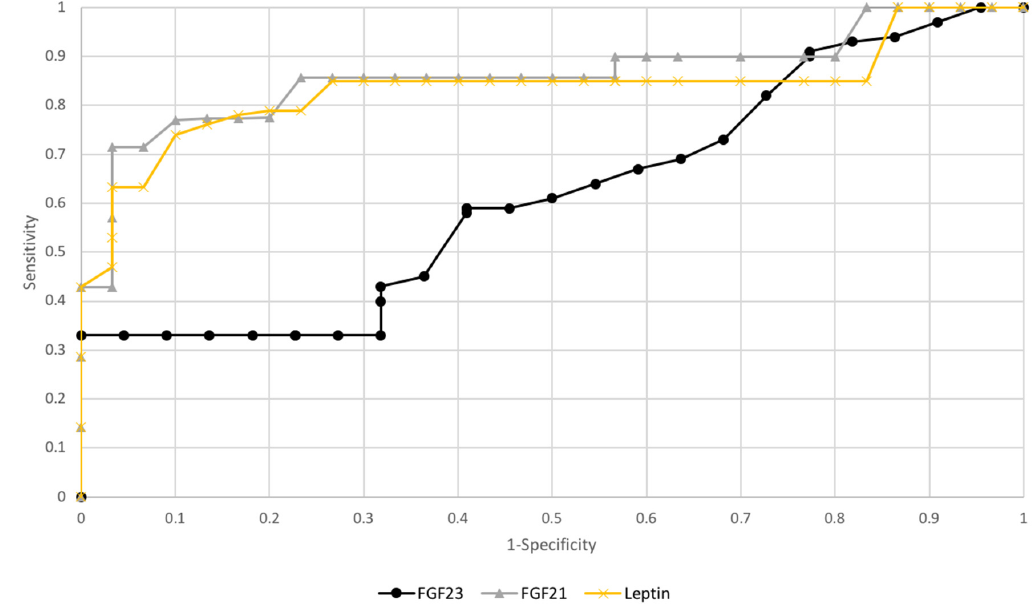
Figure 5. The receiver operating characteristic curves for proteins depending on the stage of endometrial cancer.